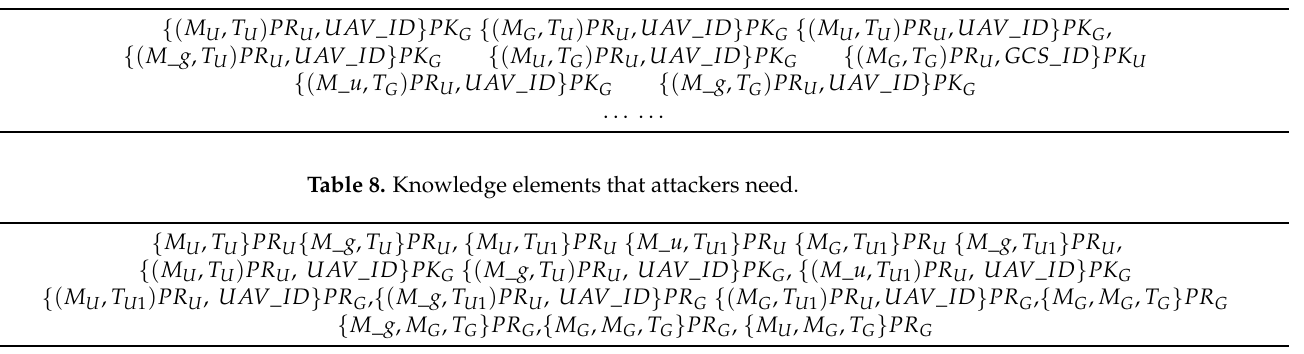
Table 7. Knowledge elements that attackers can learn.